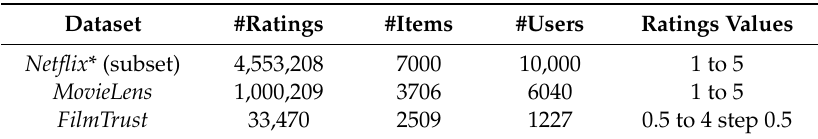
Table 1. Used datasets and their main